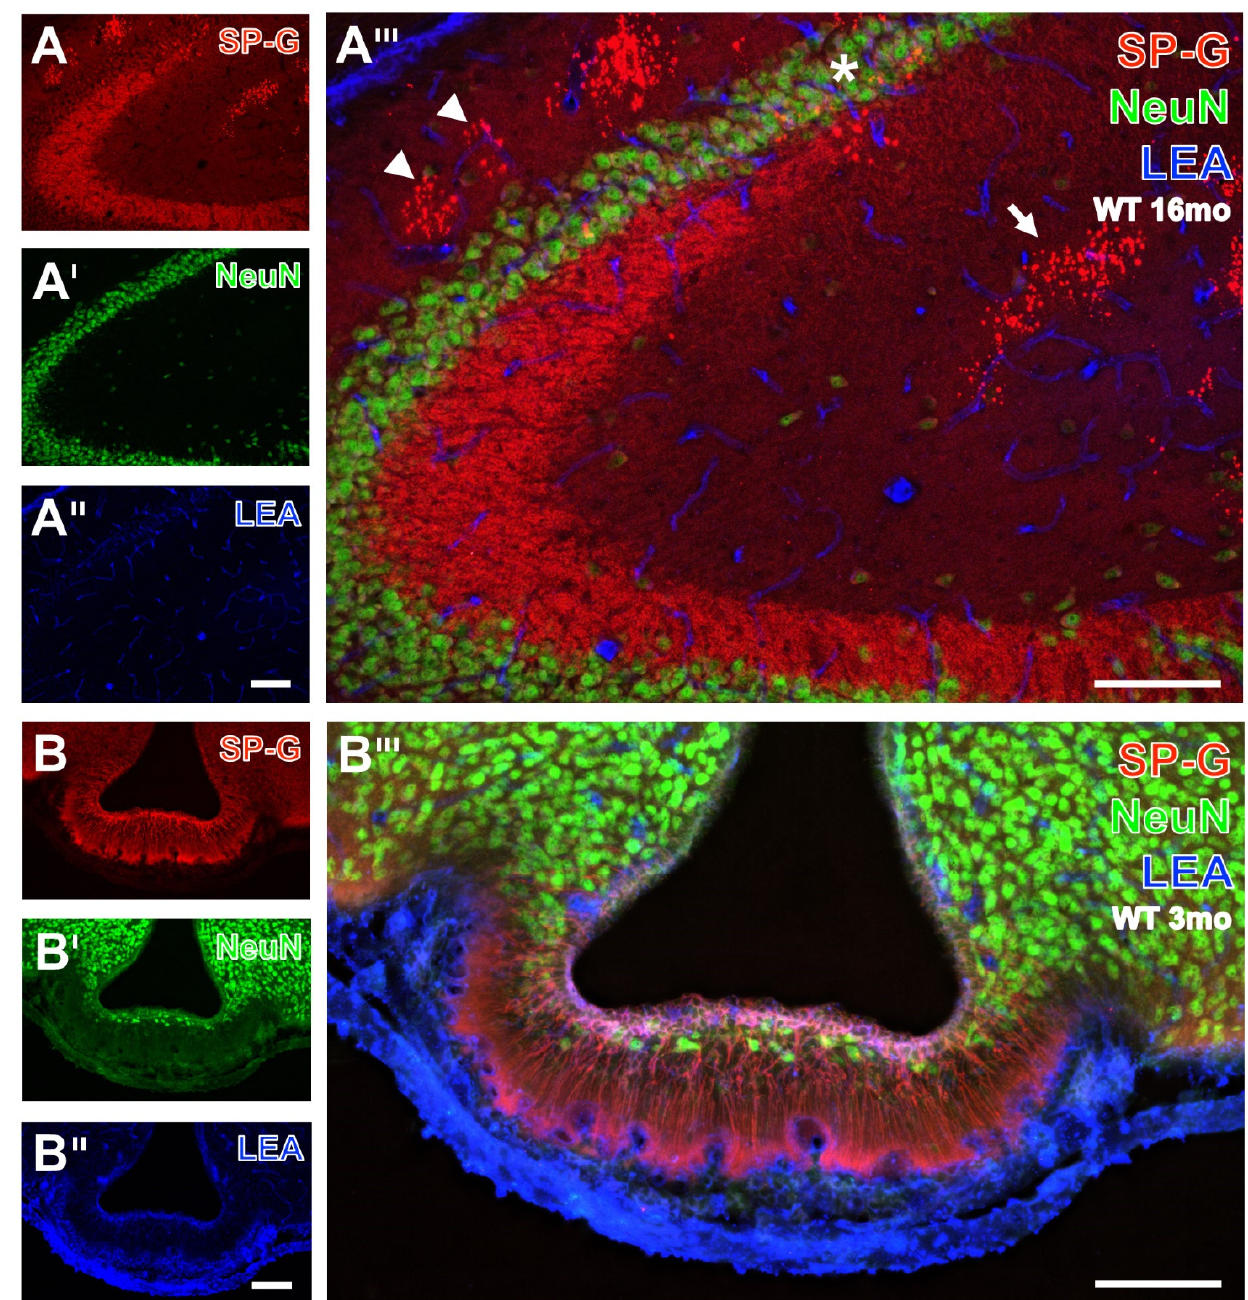
Figure 3. Triple fluorescence labeling of SP-G, LEA-positive vessels, and NeuN in hippocampus ( A – A”’ ) and infundibulum ( B – B”’ ). At a higher magnification, SP-G-ir in the hippocampus from a 16 month-old WT mouse ( A ) is visible in mossy fibers from the CA3 region and in the CA2 region but appears even stronger in clusters of dots in the stratum lacunosum-moleculare (arrow) and stratum oriens (arrowheads) of the regions CA1 and CA2. The counterstaining of NeuN-ir ( A’ ) elucidates densely packed neurons in layers, as well as some single nerve cells in the stratum lacunosum-moleculare of the regions CA2 and CA3, while the vasculature is visualized by LEA-binding sites ( A” ). The higher-magnified overlay clearly reveals clustered SP-G-immunoreactive dots in the stratum pyramidale of the CA2 region allocated with NeuN-positive neurons (asterisk). Notably, neurons of the granular layer are without detectable SP-G-ir. In ( B ), the infundibulum of a 3 month-old WT mouse shows strong SP-G-ir of fibers from putatively unmyelinated neurons and